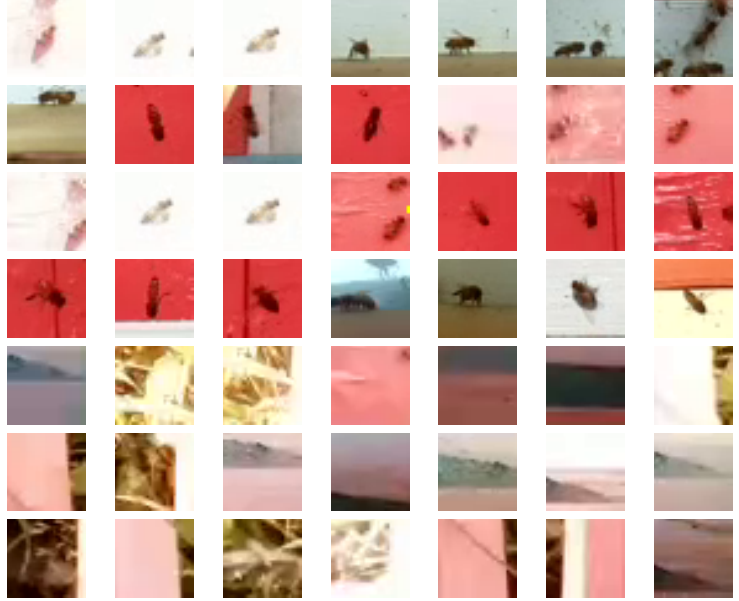
Figure 4. 49 sample images from BEE1 dataset used for experiments in [9]; first 4 rows are images manually labeled as BEE; last 3 rows are images manually labeled as NO_BEE.